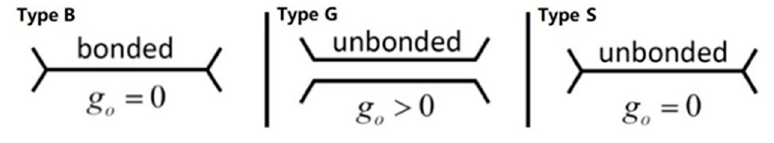
Figure 9. Initial microstructure of flat-joint contact. Figur e 9 . Initial microstructure of flat-joint contact